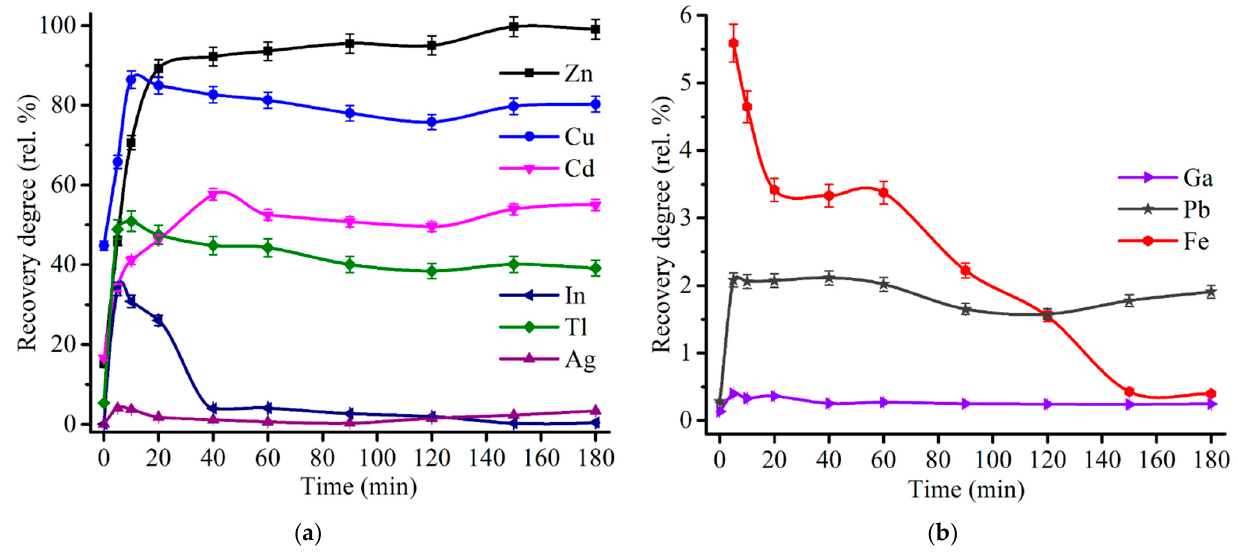
Figure 11. Effect of roasting time on the recovery degree of Zn, Cu, Cd, In, Tl, Ag ( a ), as well as Ga, Fe and Pb ( b ) at 600 °C with the addition of 48% Fe 2 (SO 4 ) 3 ∙ 9H 2 O to 100% ZPR and subsequent water leaching.